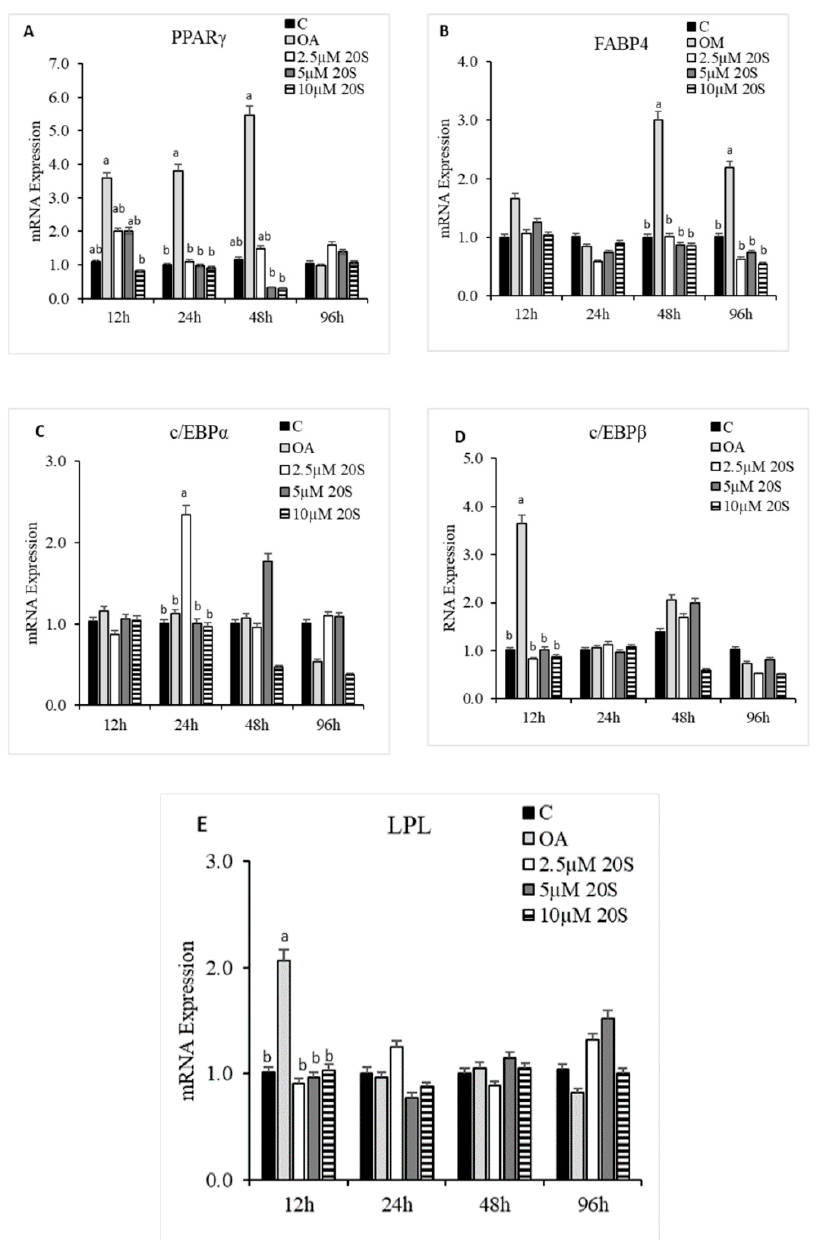
Figure 5. 20S inhibits adipogenic differentiation of mesenchymal stem cells isolated from compact bones of chicken. Cells were treated with ( A ) Control, ( B ) Oleic acid media (OA), ( C ) OA + 2.5 µM 20S, ( D ) OA + 5 µM 20S, or ( E ) OA + 10 µM 20S for 96 h. Adipocyte formation was examined by Oil Red O staining procedure. Pictures were taken by Olympus DP70 at 20X.